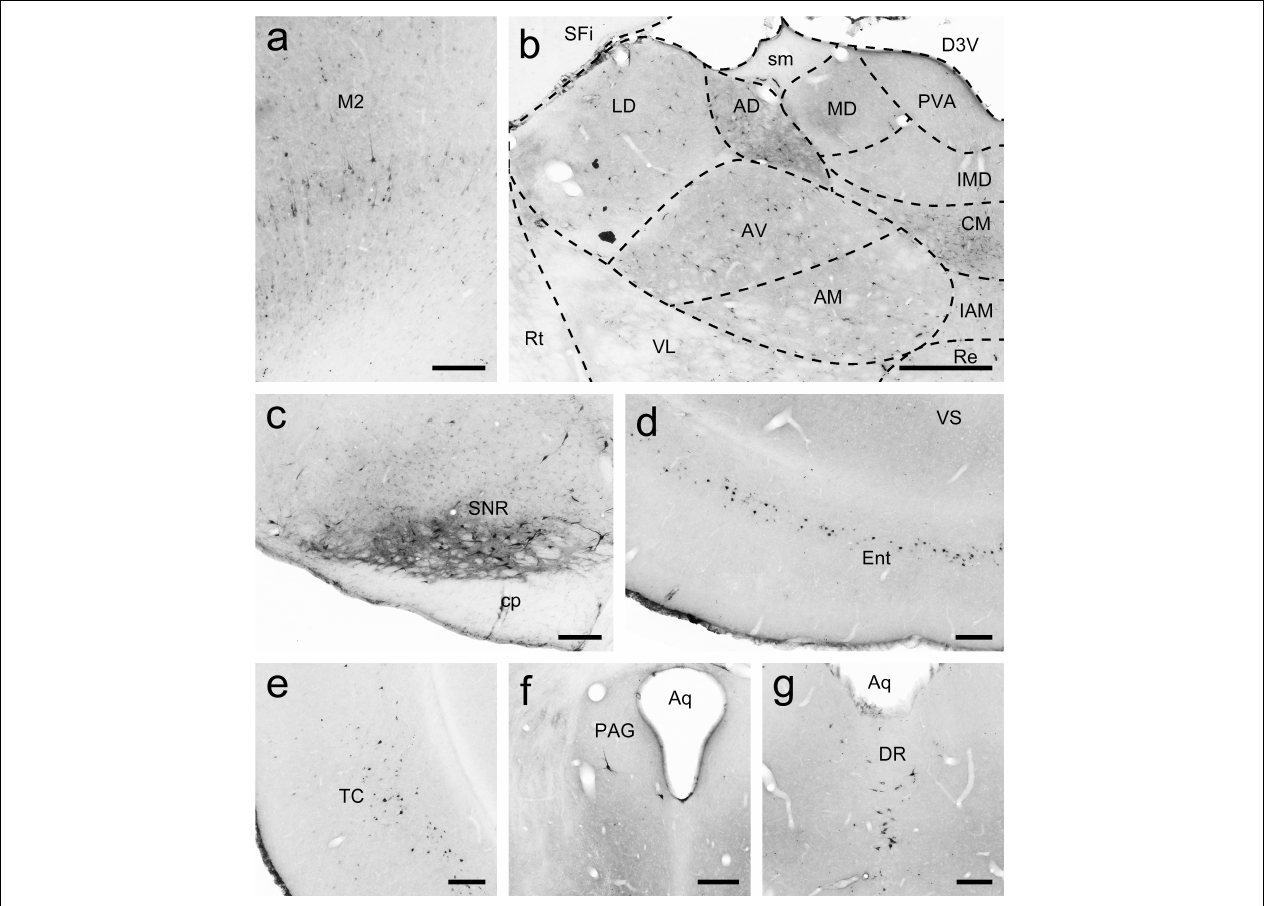
FIGURE 6 | FG-labeled neurons projecting to the caudate nucleus (Cd) were labeled in the primary motor cortex (M1; a ), thalamus (b) , reticular part of the substantia nigra (SNR; c ), entorhinal cortex (Ent; d ), temporal cortex (TC; e ), periaqueductal gray (PAG; f ), and dorsal raphe nucleus (DR; g ). The dashed line marks the boundaries between brain regions (b) . Scale bars = 200 µ m in (a,c–f) ; 500 µ m in (b)